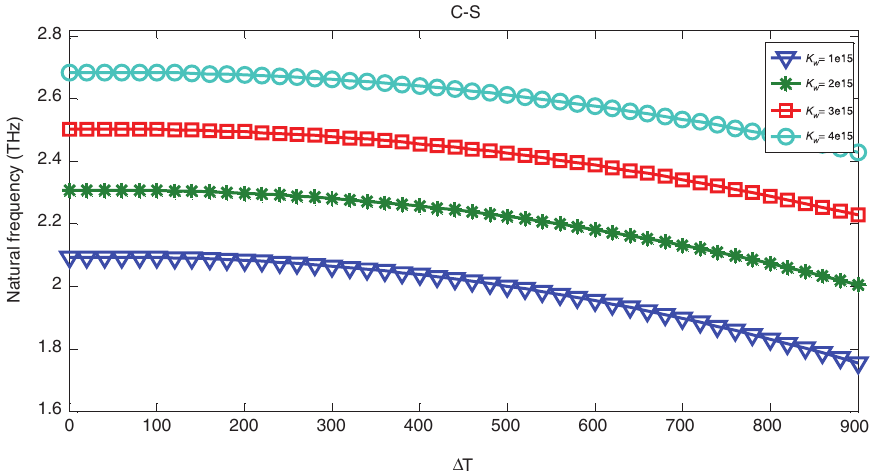
Figure 6: The effect of Winkler stiffness on the natural frequency with clamped-simply boundary